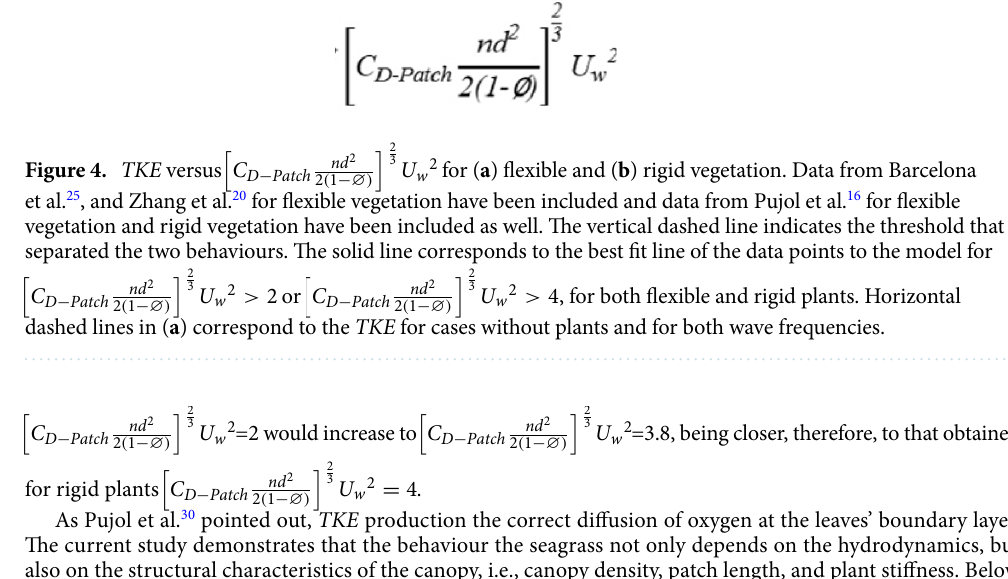
for rigid plants As Pujol et al. 30 pointed out, TKE production the correct diffusion of oxygen at the leaves’ boundary layer. The current study demonstrates that the behaviour the seagrass not only depends on the hydrodynamics, but also on the structural characteristics of the canopy, i.e., canopy density, patch length, and plant stiffness. Below